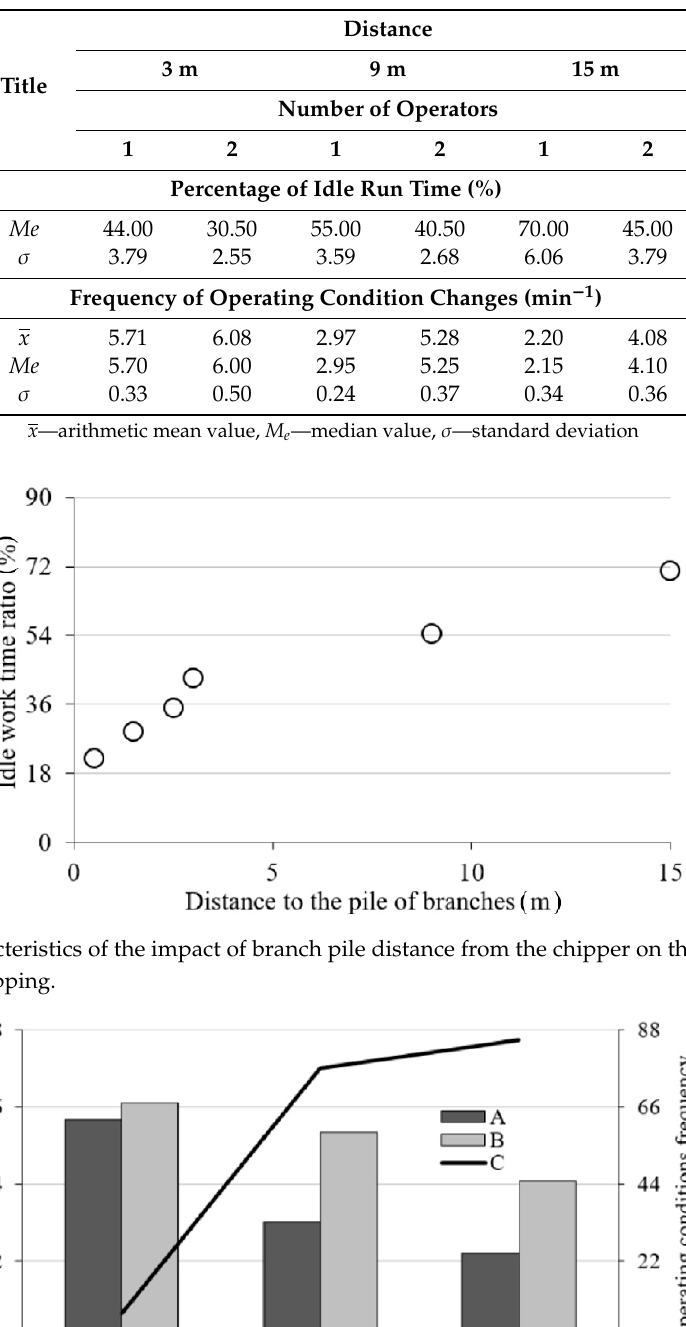
Table 2. Values obtained from measurements.